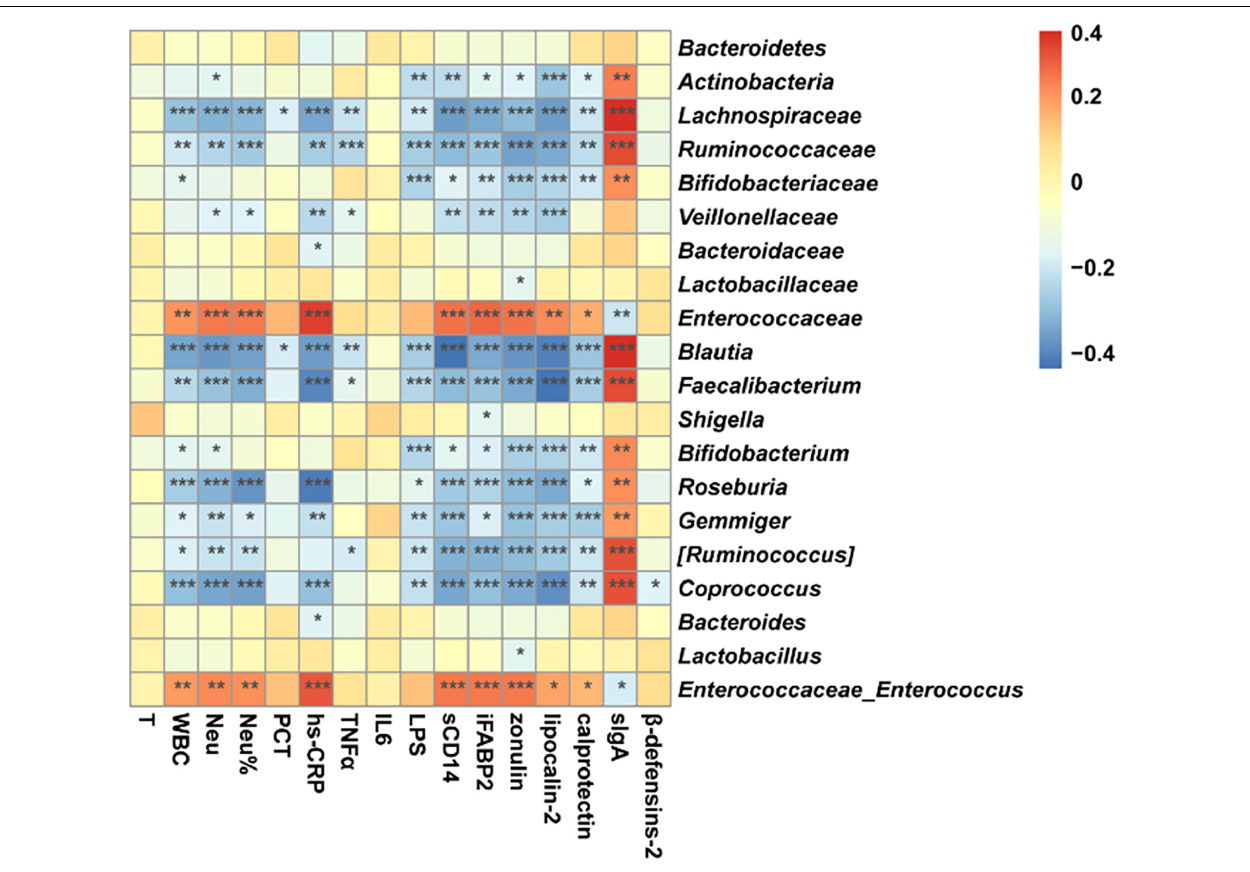
FIGURE 7 | Correlation between microbiome and parameters of systematic infection, plasma pro-inflammatory cytokines, intestinal barrier, local intestinal inflammation, and gut immunity. Star means a significant correlation, whereas P < 0.05 indicates statistical significance (* P < 0.05, ** P < 0.01, and *** P < 0.001). Orange represents negative correlation, and blue represents positive